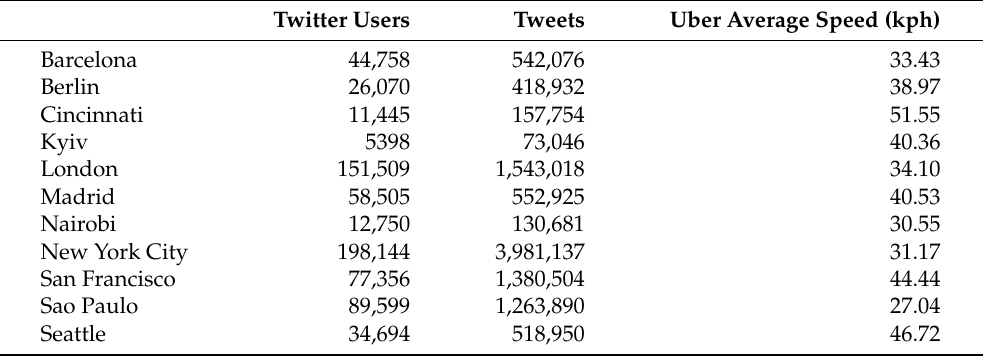
Table 3. Number of Twitter users, number of Tweets and average Uber speed for the cities used as case studies. Time period: March 2018 till November 2019.